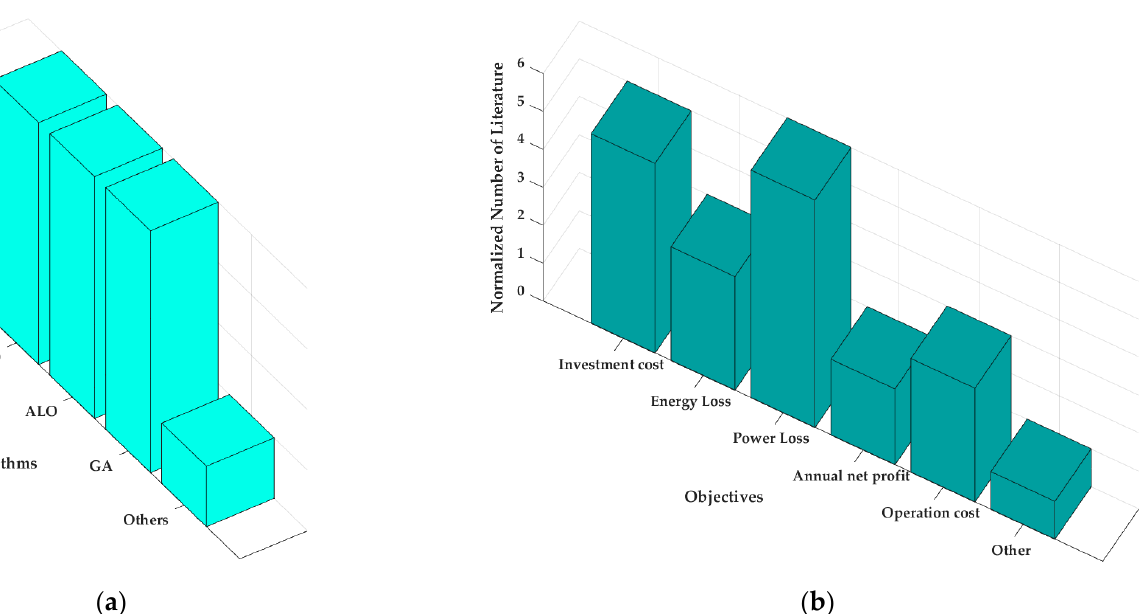
Figure 7. ( a ) The cost is related to different objectives. ( b ) Cost saving and voltage index for OPF. ( c ) Reactive and accurate PL profile.